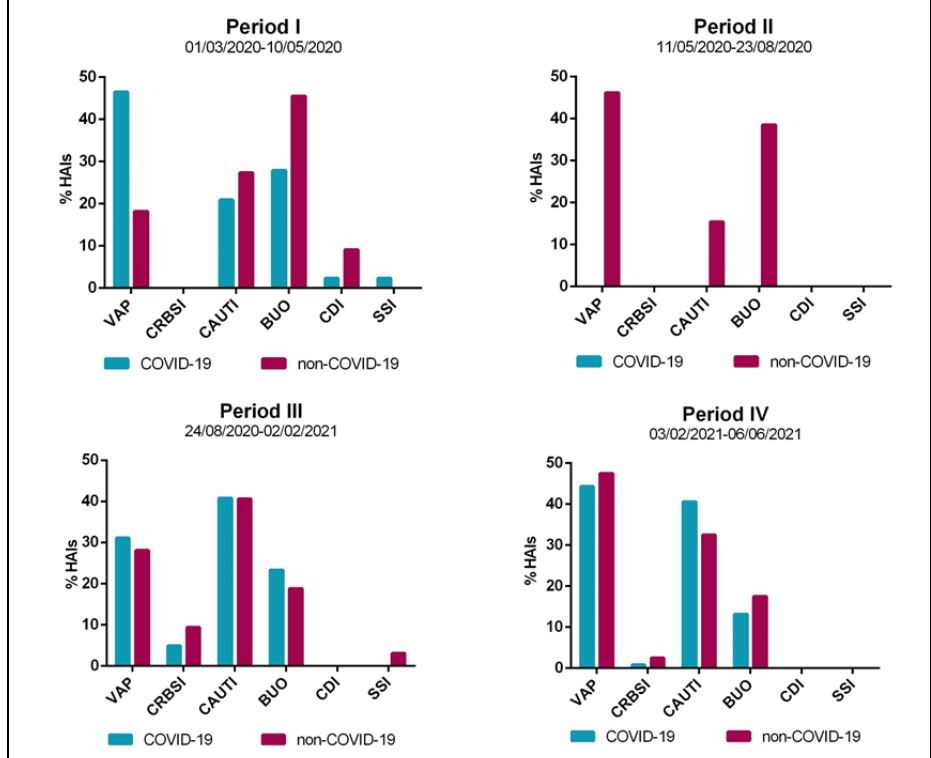
Figure 2. Characteristics of healthcare-associated infections (HAIs) diagnosed in patients admitted